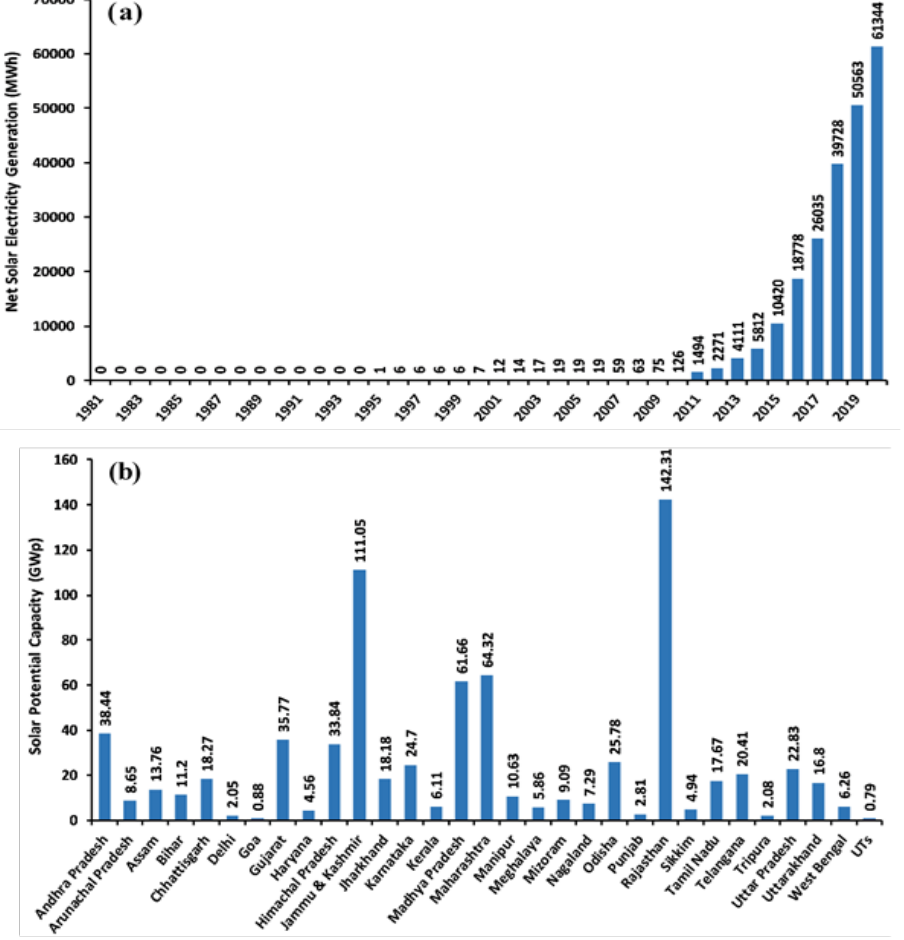
Figure 1 . (a) Time series plot for net electricity generation growth from solar energy in India and (b) state-wise estimated solar potential capacity according to MNRE annual report